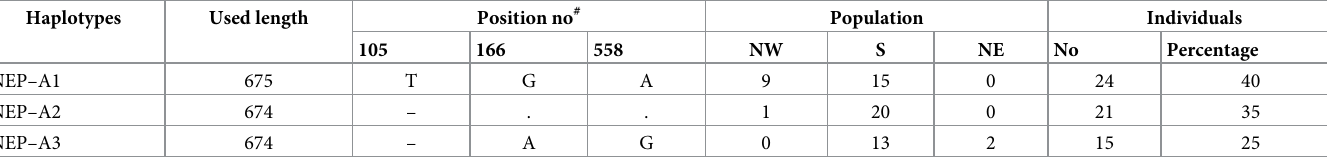
NW, northwest (Jomsom); S, south (Ghandruk, Lwang, and Sikles); NE, northeast (Manang). # The positions were numbered for a haplotype NEP-A1 from the 5’ end of sequence. Dot indicate identity with the nucleotides of NEP-A1. Dash indicates variation in the number of Ts at a T-repeat site (98–105 for